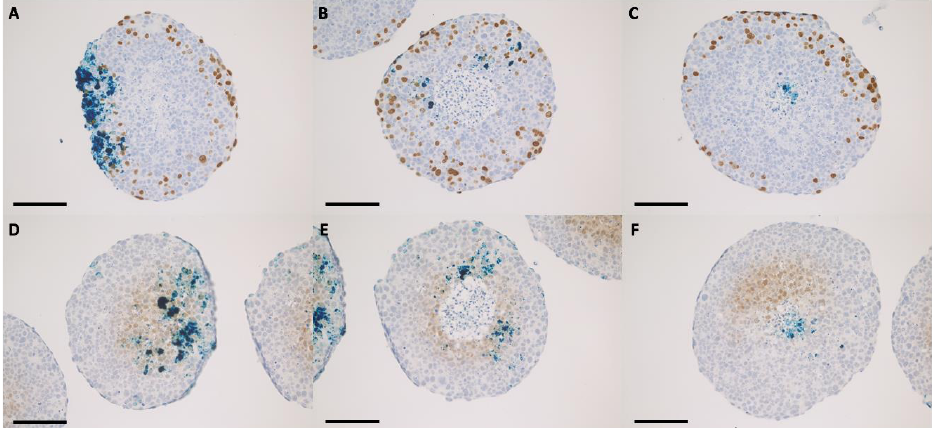
Figure 5. Bright-field microscopy images for FaDu spheroid sections that were previously incubated for 48 h with 200 μg/mL IONP DOX ; immunohistochemical staining of proliferative areas using bromodeoxyuridine ( A – C ), and of hypoxic areas using pimonidazol ( D – F ); light blue hematoxylin, dark blue IONP, dark brown proliferative cells, light brown hypoxic cells; measure bar is 100 μm.